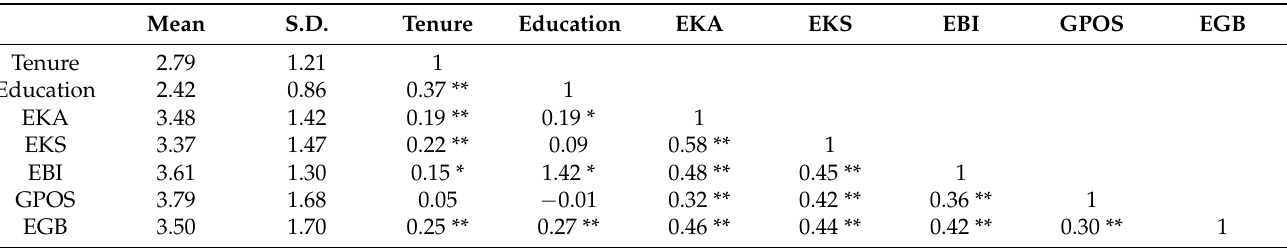
Table 4. Descriptive statistics of all